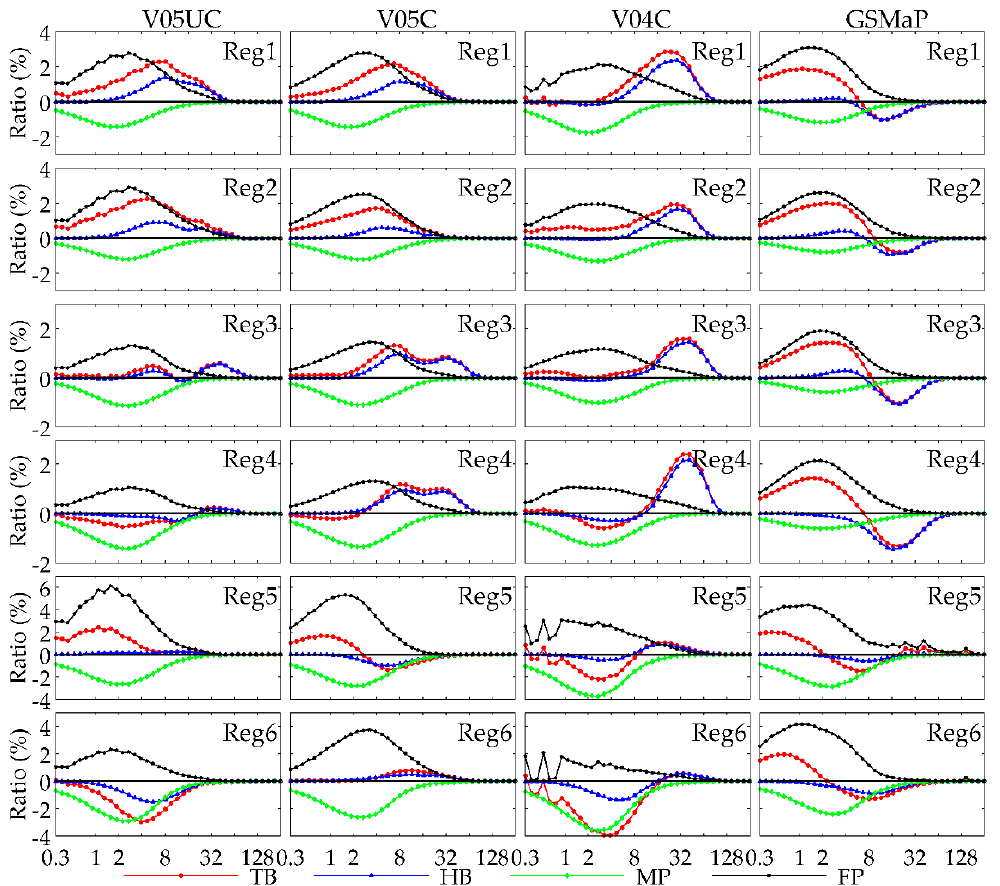
Figure 11. Probability density function of total bias, hit bias, missed precipitation, and false precipitation intensity for four GSPEs (i.e., V05UC, U05C, V04C, and GSMaP) from April 2014 to December 2016 in six selected regions.